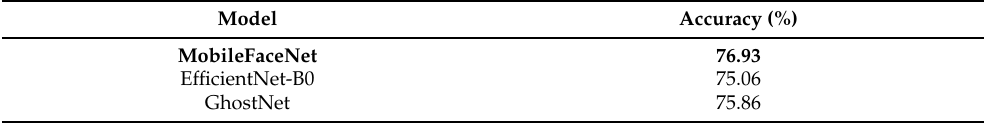
Table 8. Verification performance with the proposed evaluation subset.